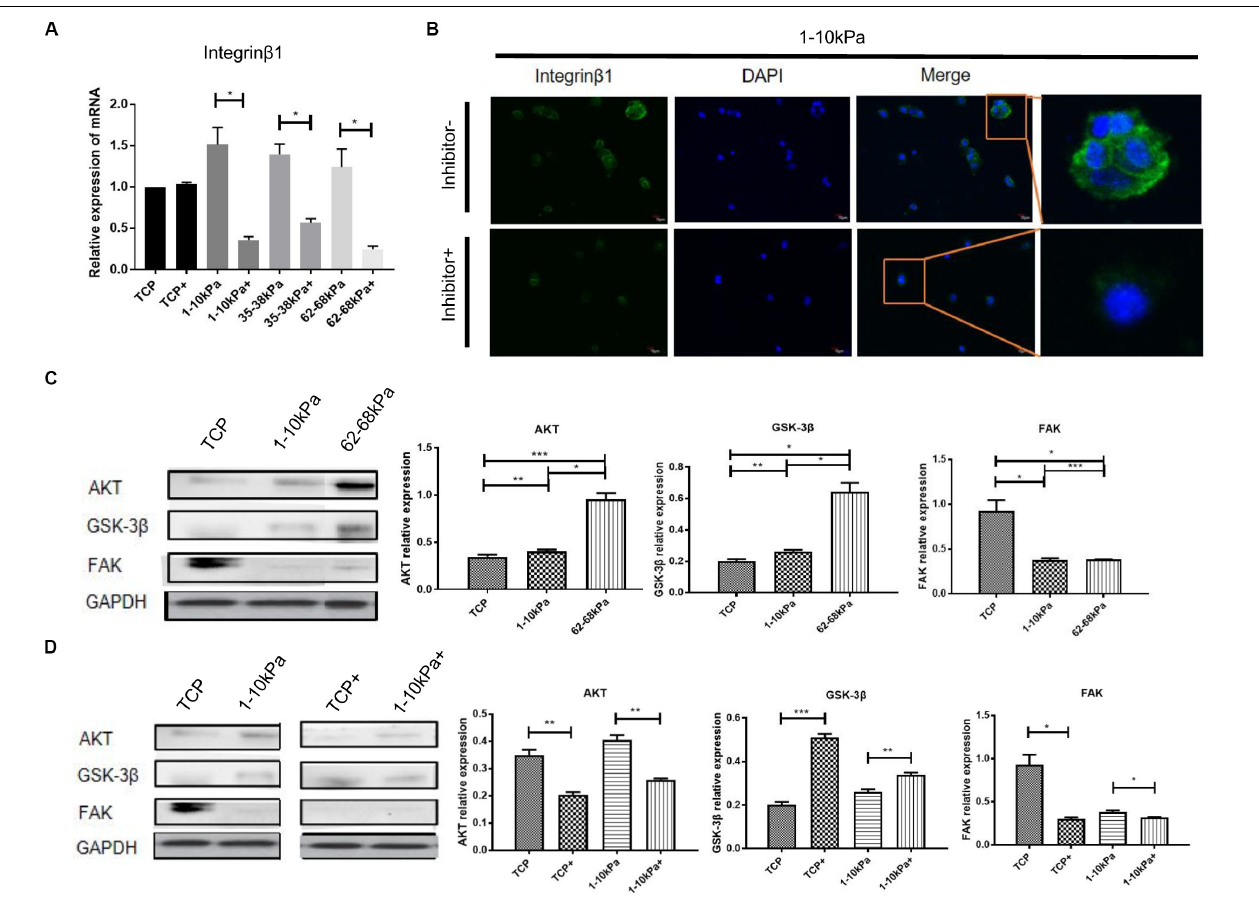
FIGURE 3 | The downstream molecules of integrin β 1 were detected after BMPR inhibition. (A) qRT-PCR analysis of integrin β 1 after BMPR inhibition for 24 h. Results are presented as mean ± SEM ( n = 5 independent experiments, * p < 0.05, and ** p < 0.01). “+”represents the group contained inhibitor. (B) Staining for integrin β 1 in hUC-MSCs, which were treated on 1–10 kPa before and after BMPR inhibition for 24 h, and then observed under a confocal microscope (Olympus FV 1200; n = 3 independent experiments, scale bars, 10 µ m). (C) Western blotting detection and statistical analysis diagram showing proteins associated with integrin β 1 including AKT, GSK-3 β , and FAK on TCP, 1–10 kPa, and 62–68 kPa before adding inhibitor (Results are presented as mean ± SEM, n = 3, * p < 0.05, ** p < 0.01, and *** p < 0.001). (D) Western blotting detection of expression of AKT, GSK-3 β , and FAK on TCP and 1–10 kPa after adding inhibitor (Results are presented as mean ± SEM, n = 3, * p < 0.05, ** p < 0.01, and *** p < 0.001). “+” represents the group contained